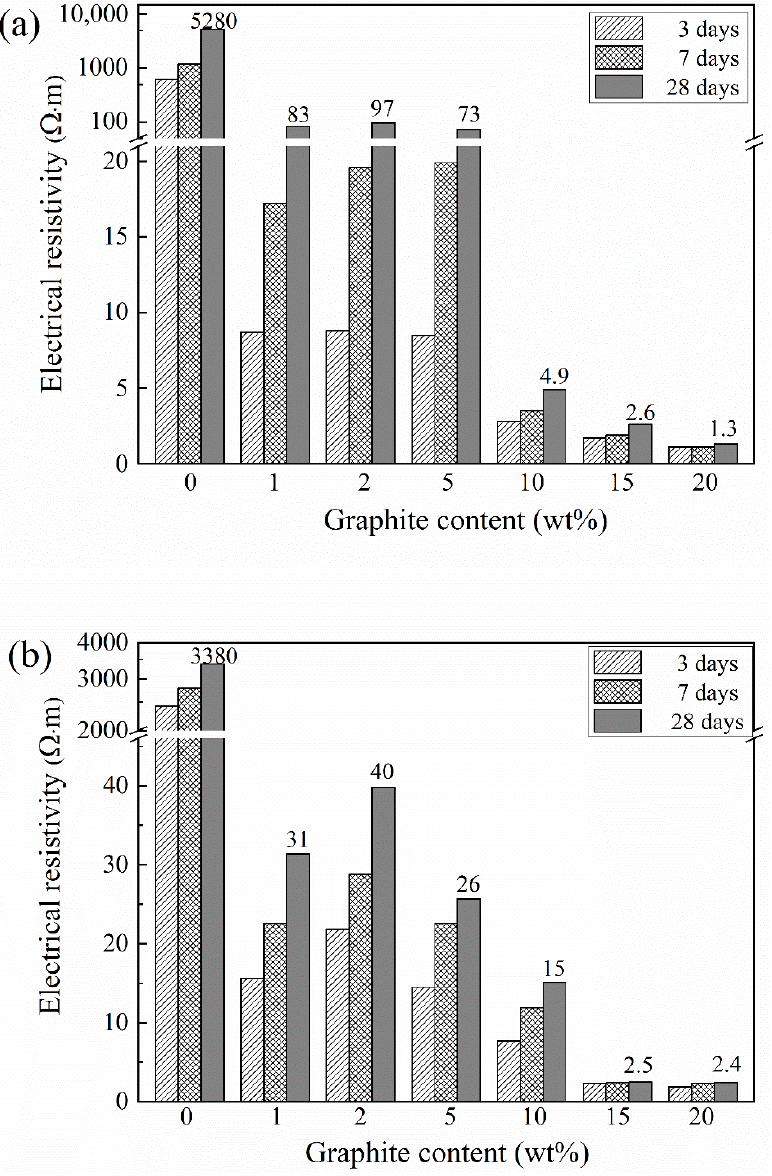
Figure 4. Effect of graphite content on the electrical resistivity of cement mortars cured for 3, 7 and 28 days with ( a ) TCS, and ( b ) standard sand as an aggregate.